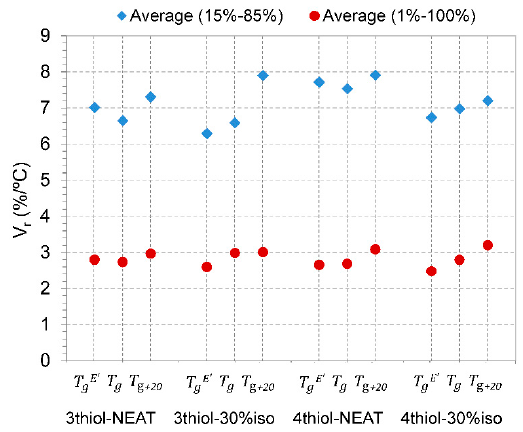
Figure 11. Shape-recovery rate (%/°C), enclosing the whole shape-recovery process (1%–100%)